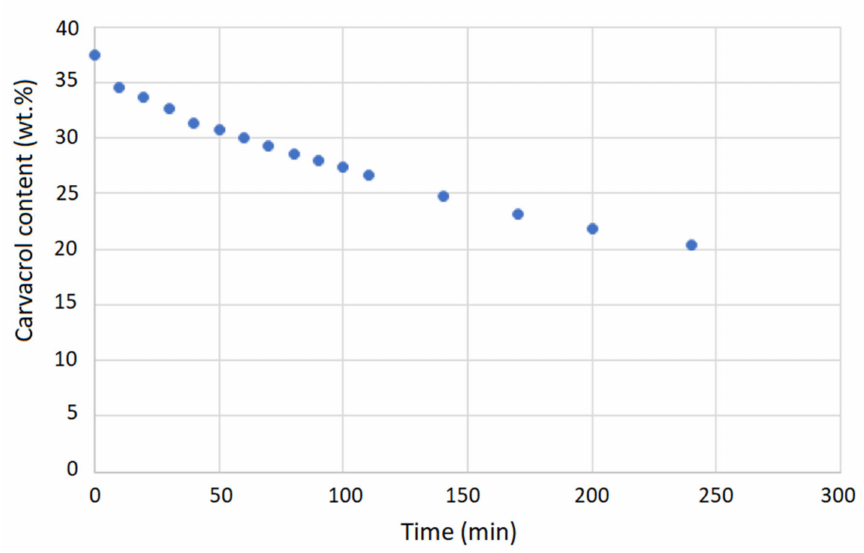
Figure 11. Carvacrol content in the membrane as a function of time (CO 2 flow rate: 5 L/min, initial carvacrol content: 37%).